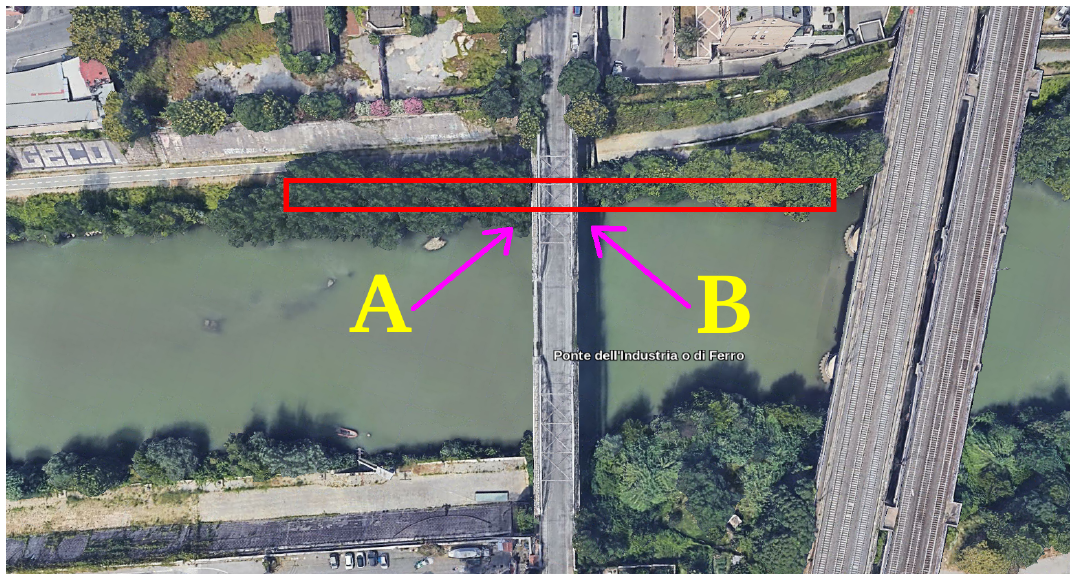
Figure 8. Optical